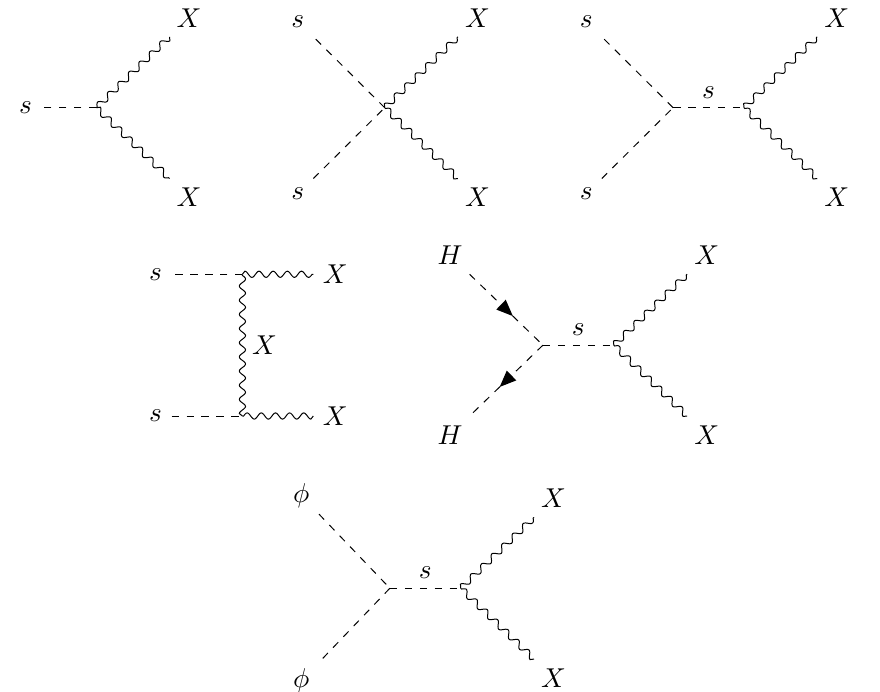
Figure 4 . Feynman diagrams showing non-thermal production channels of X